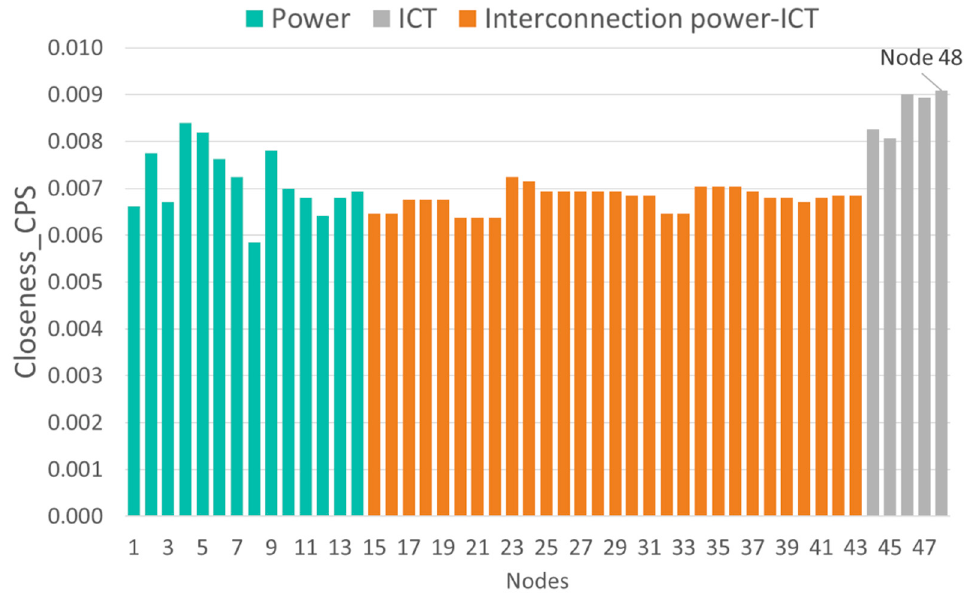
Figure 8. Closeness vulnerability values of the cyber-physical IEEE 14-bus test case.